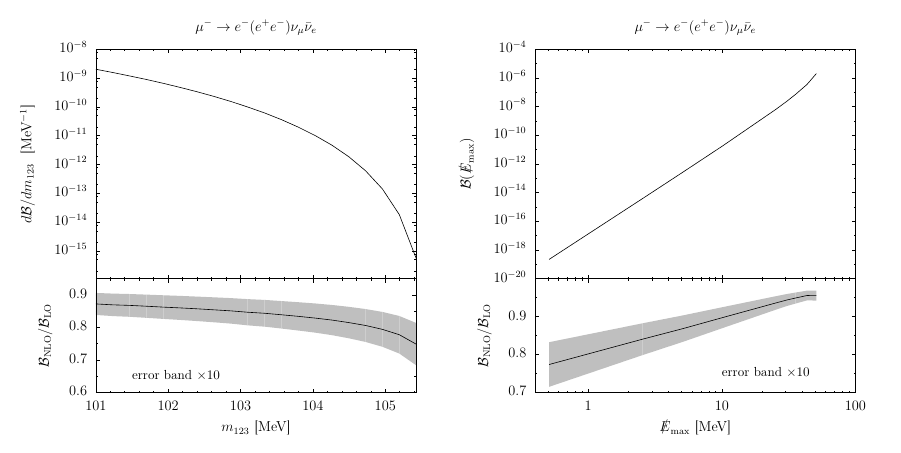
Figure 1. The branching ratio of µ → eee ν ¯ ν at NLO as a function of the invariant mass of the three electrons m 123 (left) and the cut on the invisible energy / E max (right). The ratio between the NLO and LO predictions is depicted in the lower part of each panel. The error band (magnified 10 times) represents the assigned theoretical error. Figures taken from